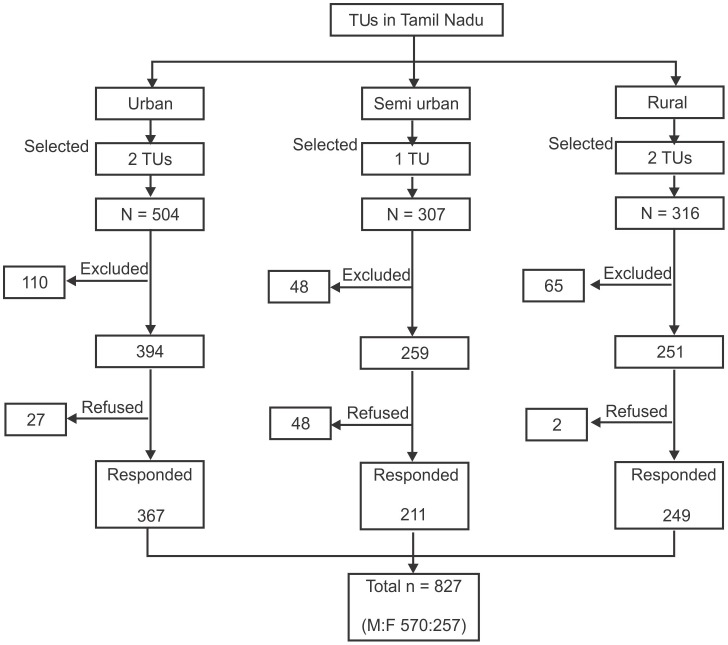
Flowchart showing the details of selection of study sites and study subjects.